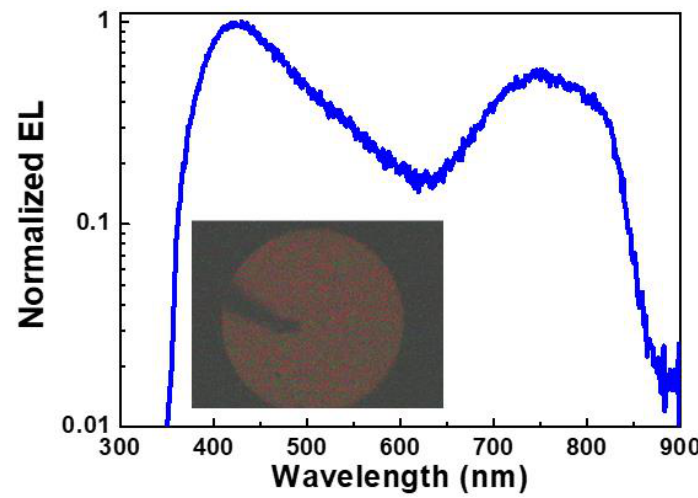
Figure 9. EL spectra of Si LEDs by using the SiN x film as host matrix. Inset: The photographs of corresponding EL emission pattern.